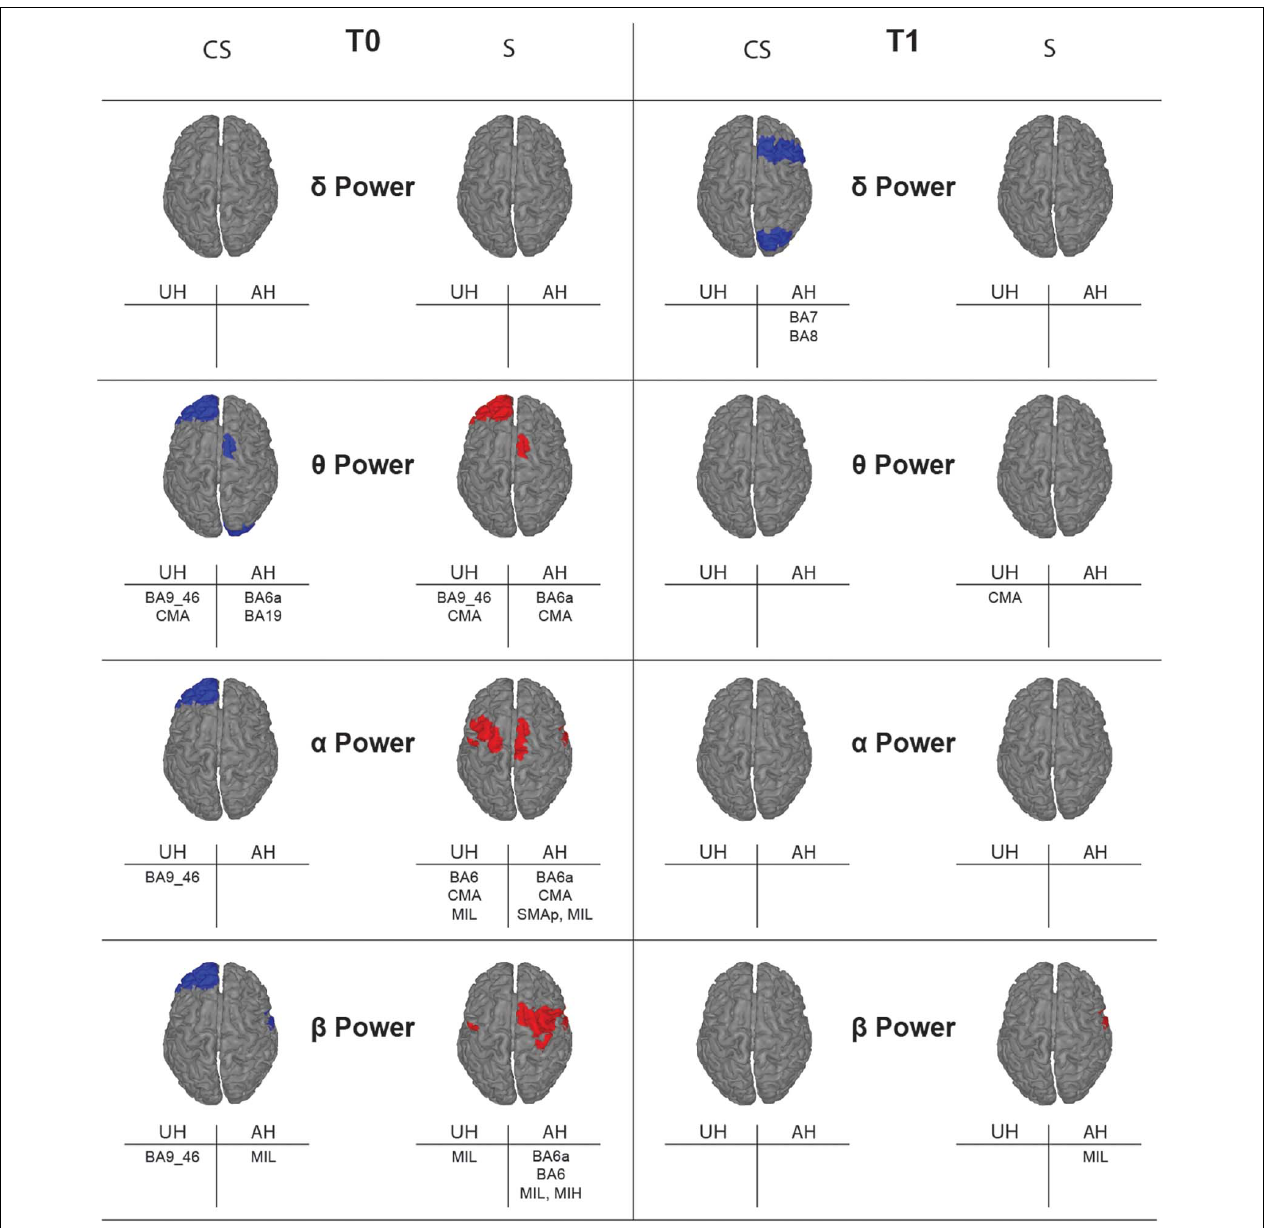
FIGURE 4 | Topographic map showing significant differences of average power for the reconstructed ROIs between healthy subjects ( H ) and stroke patients ( CS , cortico-subcortical and S , subcortical) at T0 (left panels) and T1 (right panels) in each band of interest. ROIs with significantly higher power ( p < 0.05) in one of the stroke subgroups than in the healthy group are colored, in blue for CS and in red for S . Labels of significantly different ROIs are reported at the bottom of the corresponding image (for the correspondence between the ROI label and its full name see section “Materials and